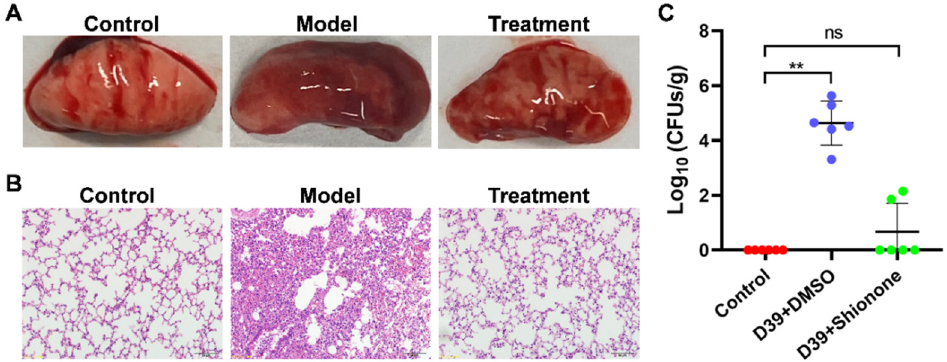
Figure 4. Shionone alleviates mice pneumonia injury induced by S. pneumoniae . ( A , B ) Gross lung tissue lesions and hematoxylin/eosin staining analysis after infected for 48 h with or without 50 mg/kg shionone treatment. ( C ) Lung colony count of the control, model, and treatment groups after infection for 48 h. The significance level was expressed as follows: ** p < 0.01; NS, no significant difference.